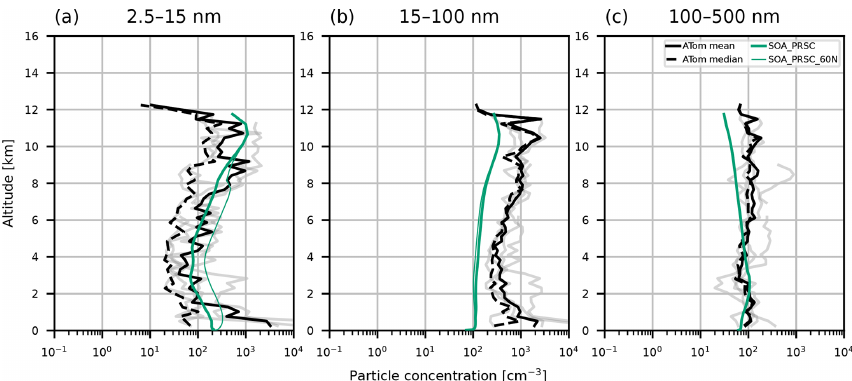
Figure D2. Aerosol vertical profiles from model output and ATom campaign observations. Model output is from collocated monthly mean values from simulations SOA_PRSC (thick dark green) and SOA_PRSC_60N (thin dark green). ATom observations are taken from leg 1 of the campaign and restricted to measurements that were taken north of 60 ◦ N. Observations correspond to mean profiles from different days (grey lines), the overall mean (solid black lines), and overall median (dashed black lines). Profiles are for particles with size (a) 5–10nm, (b) 10–100nm, and (c) 100–500nm. Observations were recorded at standard temperature and pressure; model output has been adjusted to account for